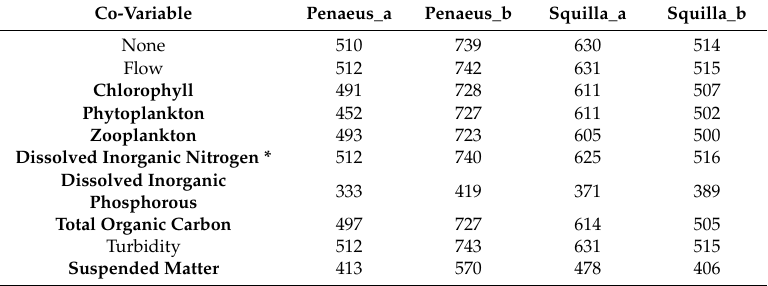
Table 8. Akaike Information Criterion (AIC) for di ff erent covariables (see details in Table 3), obtained employing integrated, autoregressive, moving average (ARIMA) time series models on the selected fishery taxa and technique (a: trawling; b: other techniques). The co-variables that reduced the AIC are in bold.